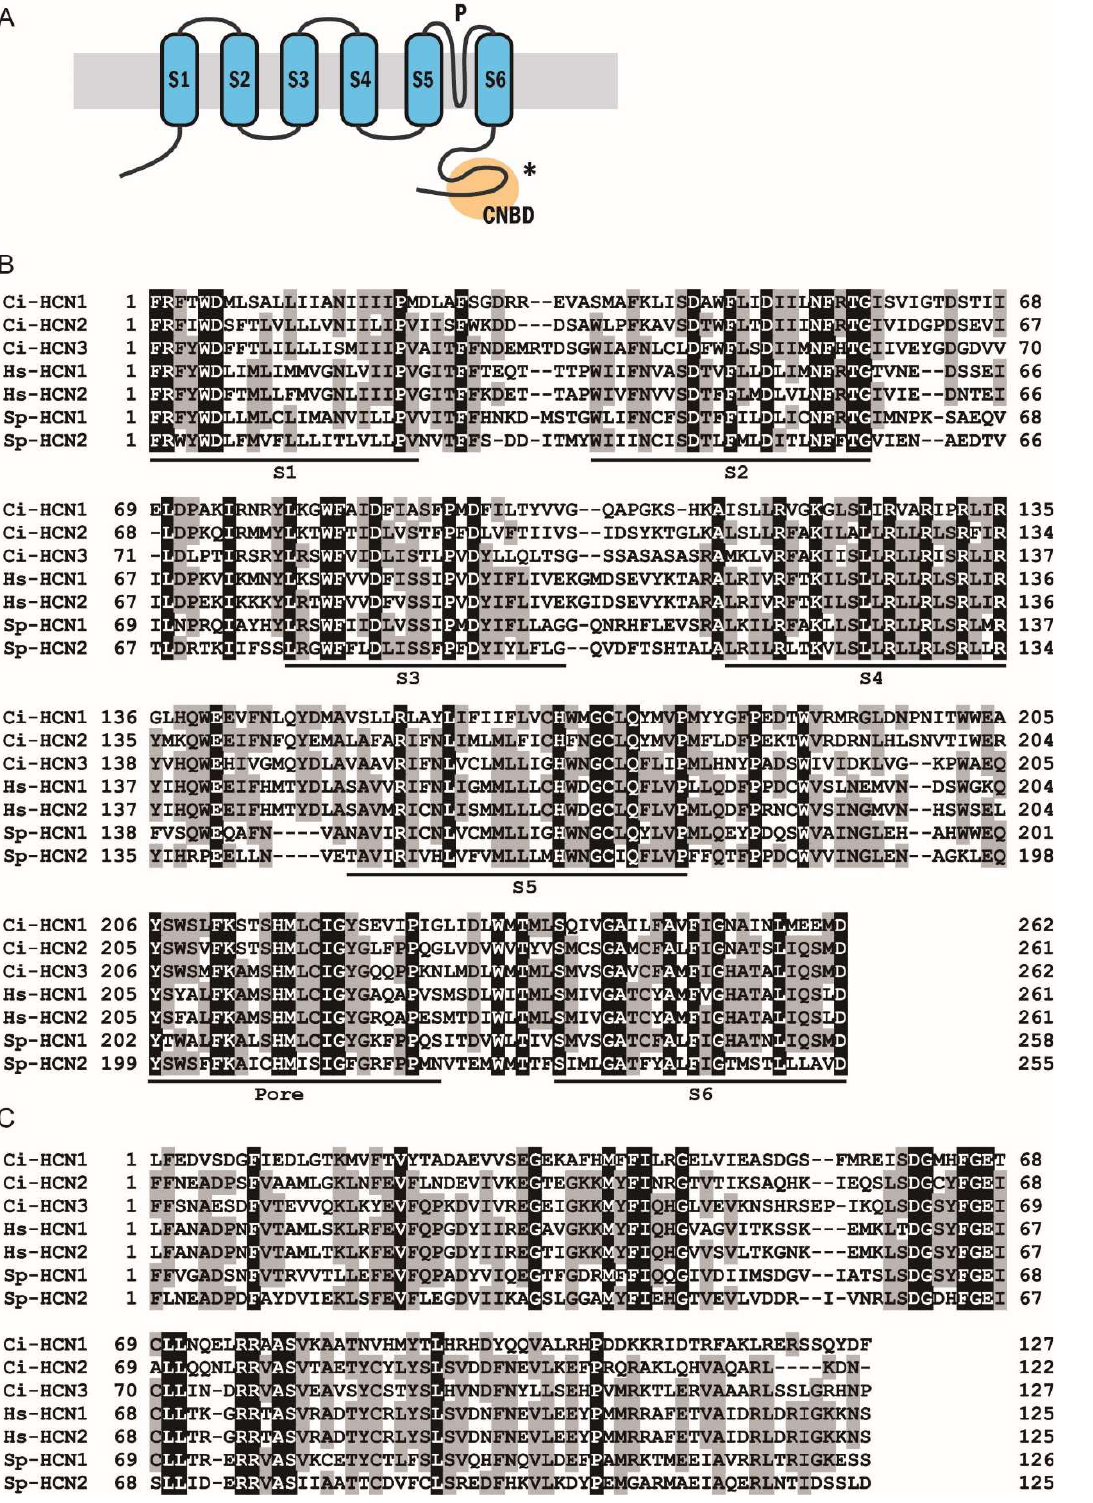
Figure 3. ( A ) Schematic representation of the HCN channel. * The asterisk shows the region used for antigen to raise a polyclonal antibody. ( B ) Amino acid sequence alignment of the transmembrane segments S1–6 and the pore region from the Sp-HCN1, 2, Ci-HCN1 and 2. ( C ) Amino acid sequence alignment of the cyclic nucleotide-binding domain (CNBD) from the Sp-HCN1, 2, Ci-HCN1 and 2.